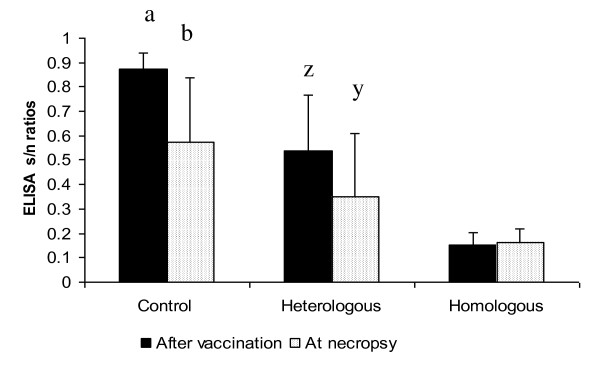
Paired influenza A Multiscreen ELISA s/n values against the nucleoprotein of influenza virus two weeks after vaccination (prior to exposure) and at necropsy (bars represent the mean of s/n values (± SD) to influenza ■ after vaccination, □ at necropsy. Positive s/n < 0.673; negative s/n > 0.673. a,b and z,y Statistically significant differences between paired samples for the NV and HE groups before exposure and at necropsy (p < 0.05).